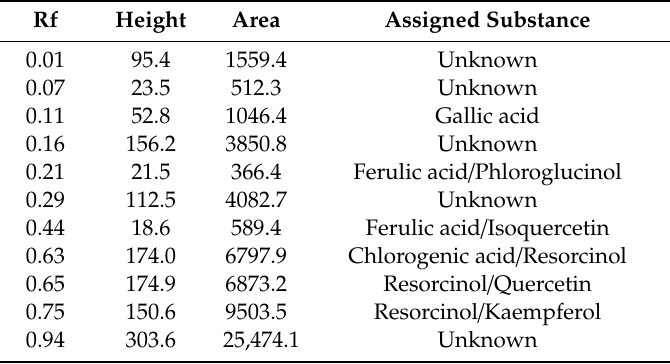
Figure 1. Total Phenolic Profile and Chromatogram of A. aethiopicum . ( A ): HPTLC profile of A.aethiopicum under visible light; ( B ): HPTLC profile of A. aethiopicum under UV light at 366nm before derivatization; ( C ): HPTLC profile of A. aethiopicum under UV light at 234 nm before derivatization; ( D ): HPTLC profile of A. aethiopicum under visible light after derivatization; (E) : HPTLC profile of A. aethiopicum under UV lightat366nmafterderivatization; ( F ):HPTLCchromatogramofethanolicextractsof A.aethiopicum -base line display scanned at 254 nm; ( G ): HPTLC chromatogram of ethanolic extracts of A. aethiopicum -peak densitogram display scanned at 254 nm; ( H ): HPTLC profile of standard—peak baseline display scanned at 254 nm; ( I ): HPTLC chromatogram of standard Quercetin—peak densitogram display scanned at 254 nm. Table 1. HPTLC Total Phenolic profile of A. aethiopicum methanolic